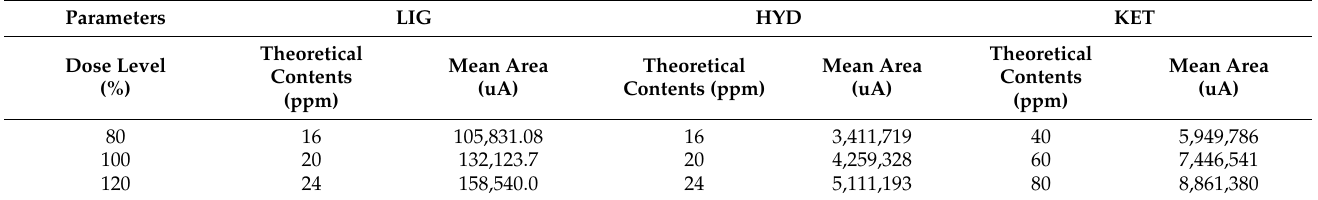
Table 2. Theoretical contents and dose levels of analyte prepared in the study against the respective mean area of retentive peaks at 100% analytical concentration.